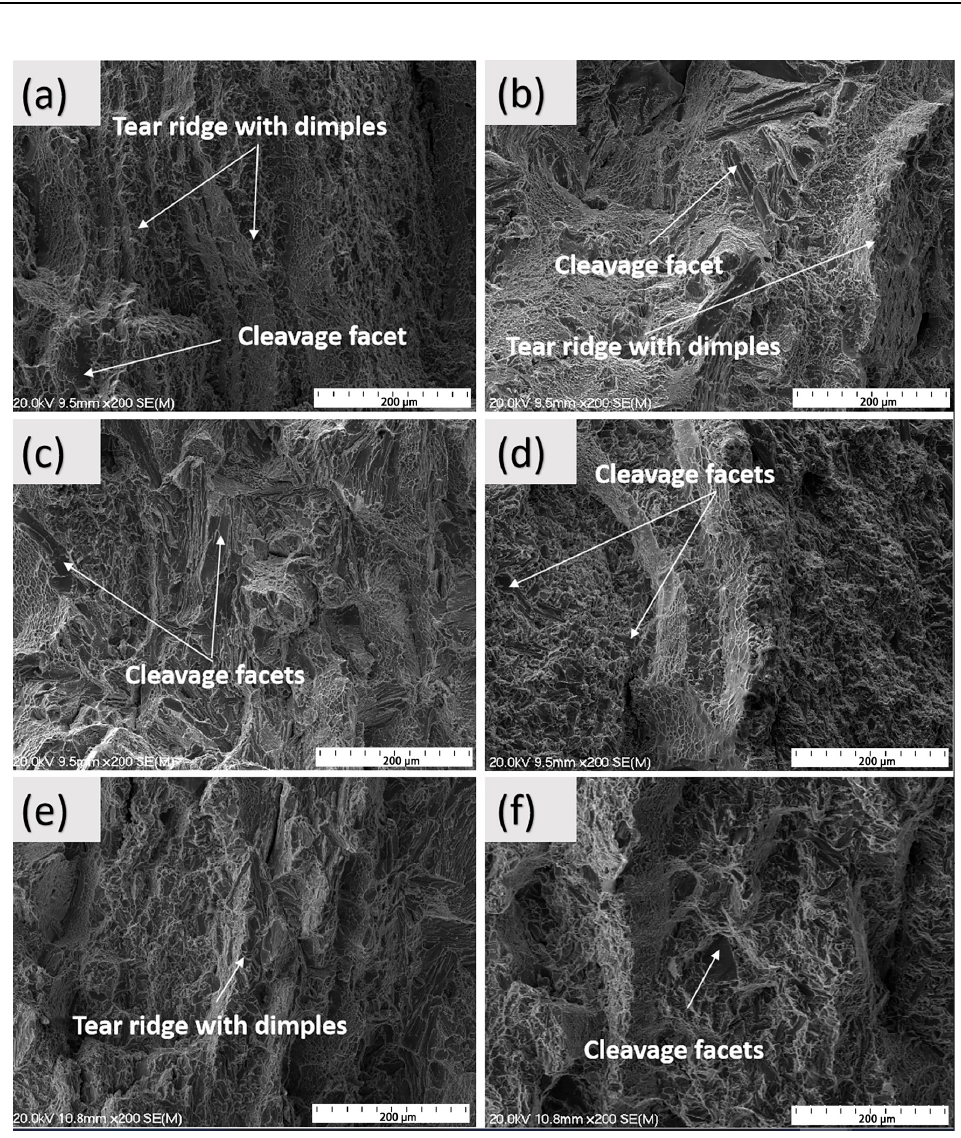
Figure 10. SEM fracture morphology of as-processed composites: ( a ) Chips-Ti64-1TiB; ( b ) Chips- Ti64-3TiB; ( c ) Chips-Ti64-5TiB; ( d ) Chips-Ti64-7TiB; ( e ) Chips-STA-855; and ( f ) Chips-STA-955.